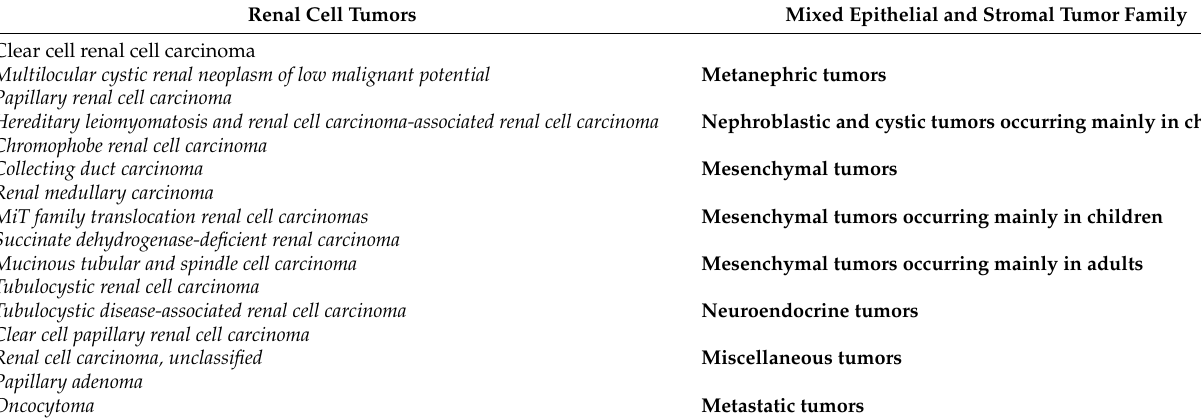
Table 1. 2016 WHO classification of kidney tumors, focus on the subclassification of renal cell tumors